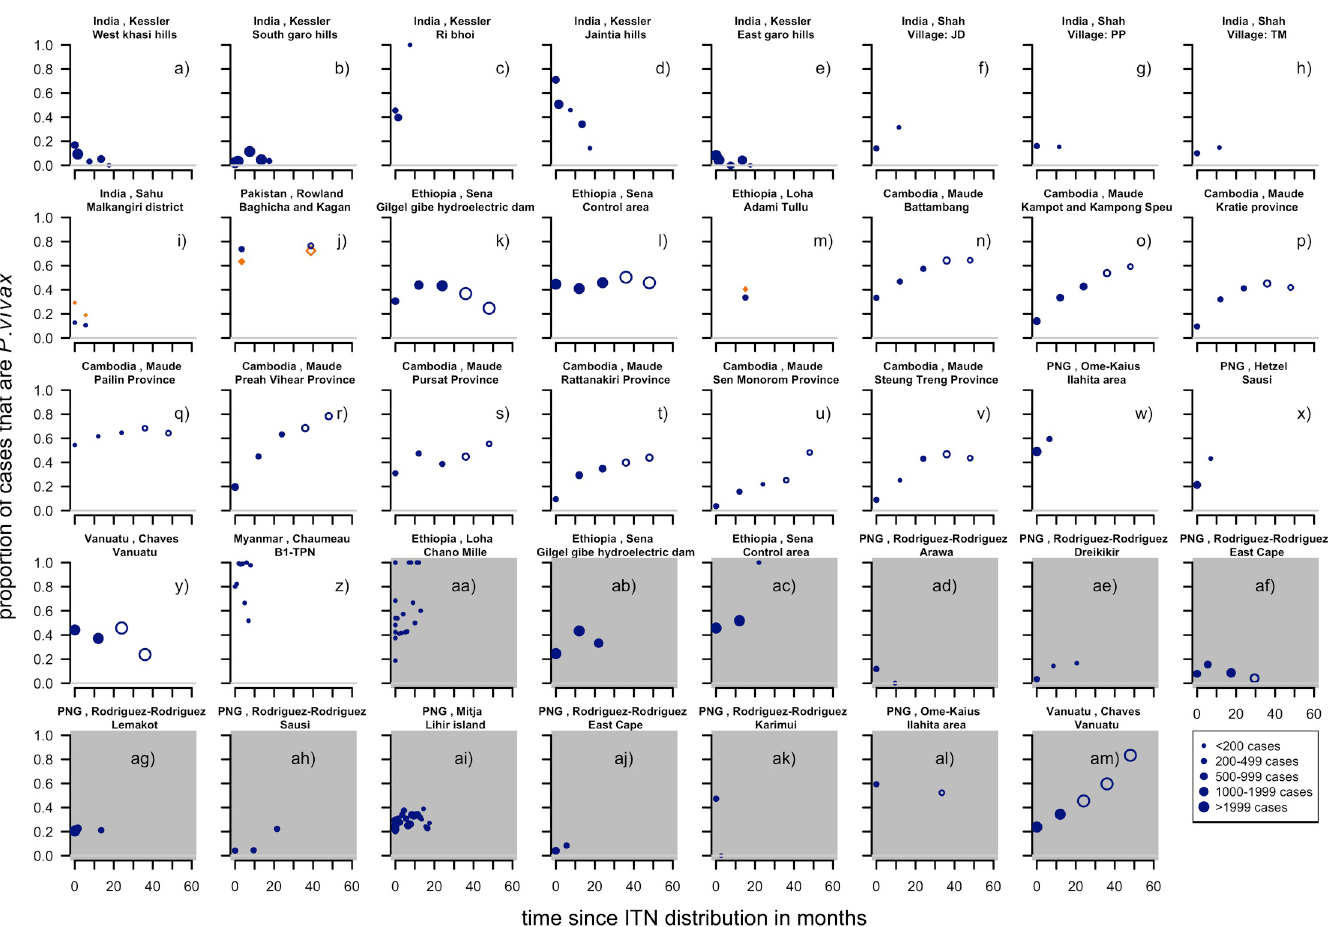
Fig 3. Proportion of clinical cases with P. vivax infection by time since first ITN distribution (white background) or repeated ITN distribution (grey background). Blue filled circles: proportion of cases with P. vivax infection up to 24 months from the intervention. Open circles: over 24 months after the intervention happened (excluded in the analysis because focus was on the dynamics in the first 2 years after the intervention). Orange diamonds: the proportions in the control groups. Dots at time-point 0 were not necessarily measured at this time but at time-points before the intervention (median 2.2 months before implementation, range 0–24 months before) and it was assumed that this represents the proportion just before the intervention was implemented (Methods, Definitions of variables, Time since implemention). Dot size depends on number of cases found.